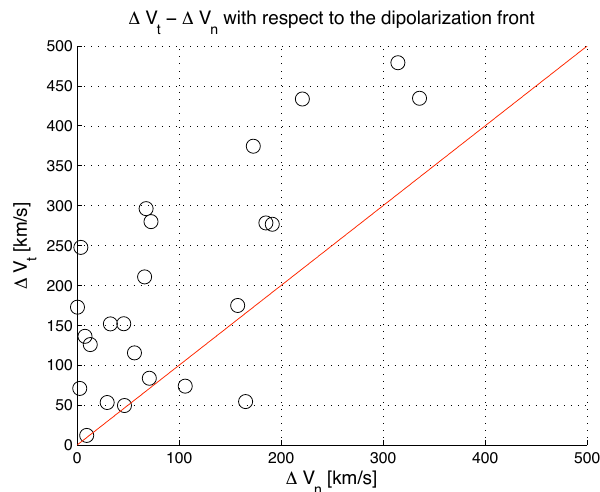
Fig. 7. Relationship between the perpendicular plasma velocity, the estimated timing velocity of the 24 dipolarization events. First we obtained the mean average perpendicular plasma velocity V ⊥ dur- ing the dipolarization (between B z , min and B z , max ). Then the ve- locity difference between the estimated mean plasma velocity and the estimated timing velocity V timing was determined. Then the ve- locity difference was projected onto the timing velocity vector and the parallel 1V t and perpendicular components 1V n were evaluated and